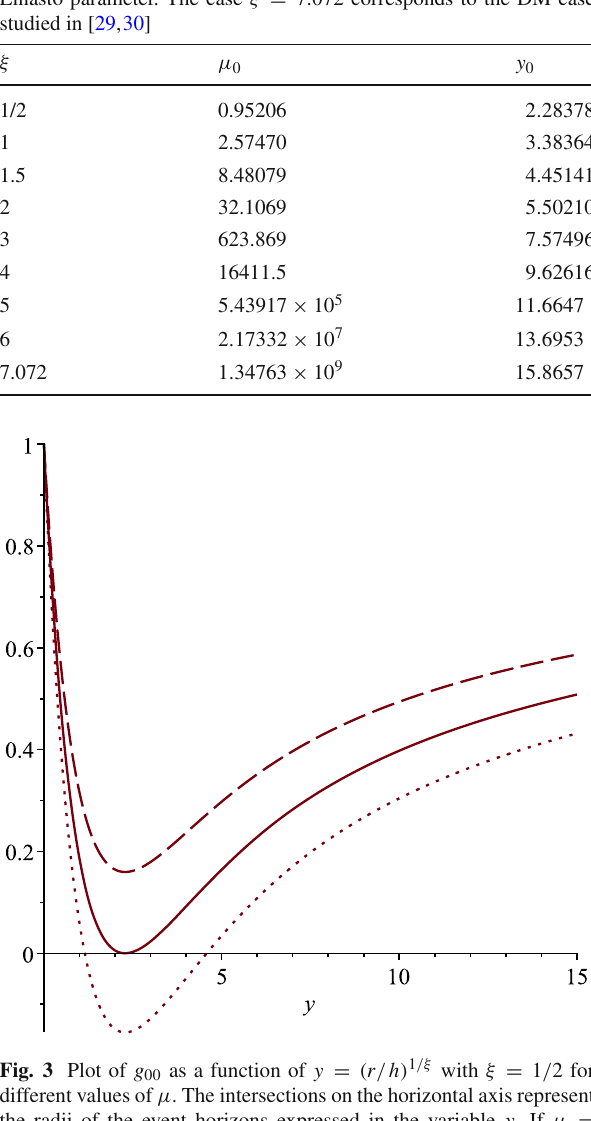
= 2 . 28378 (solid 0